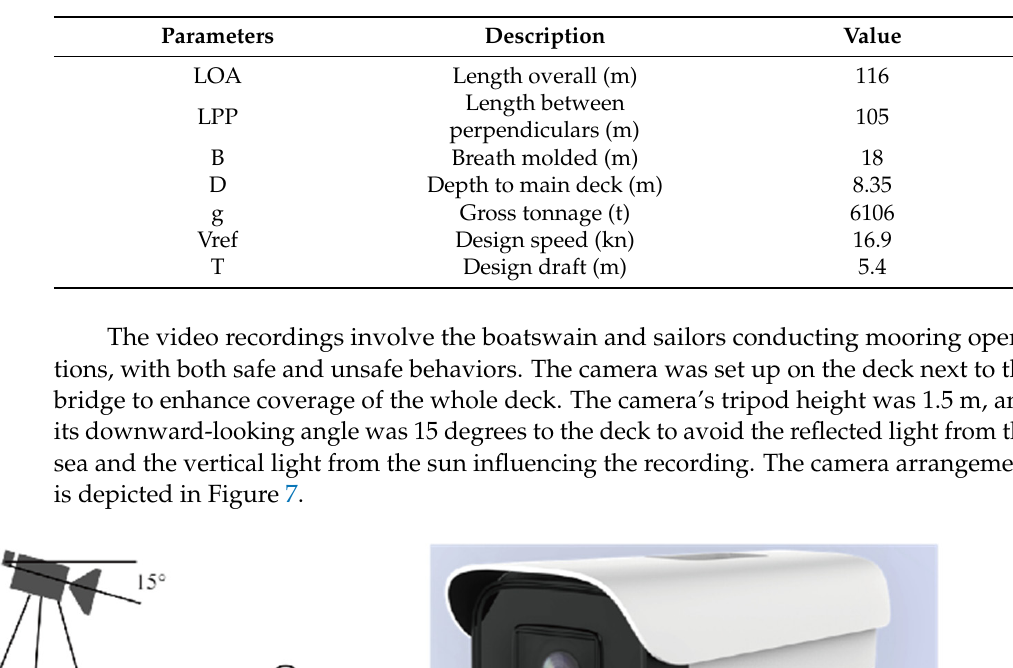
Figure 6. Research and training ship “YuKun”. Table 2. Main particulars of M.V. YuKun.